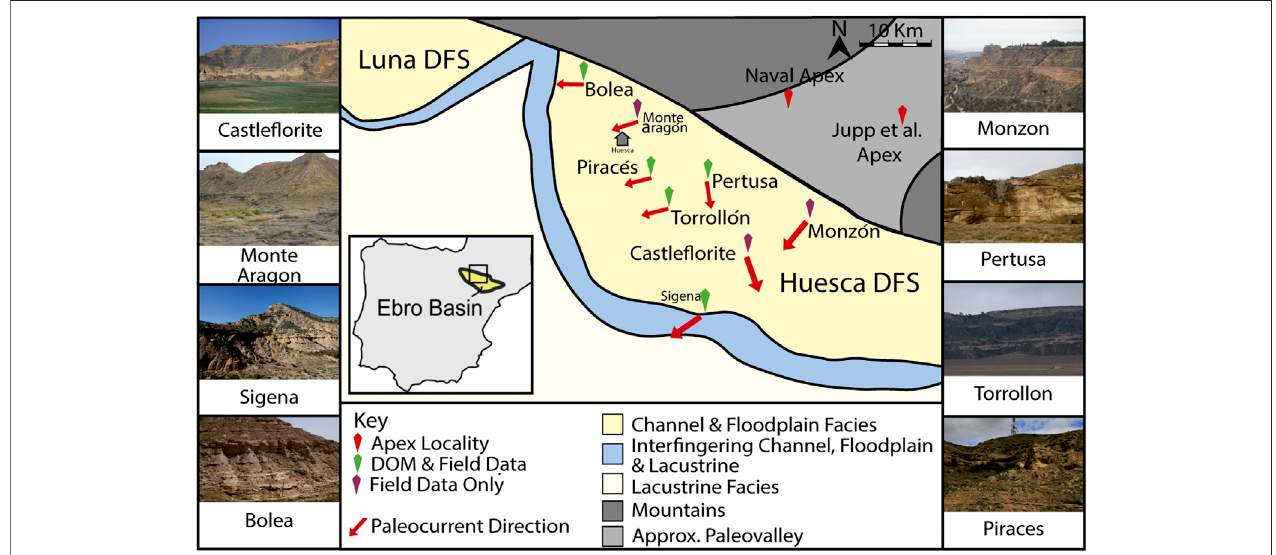
FIGURE 1 | Location map showing the Ebro Basin. DOM (cid:1) digital outcrop models. Position of two calculated apices (Naval and Jupp et al., 1987) are plotted (see text fordiscussion)aswellaspositionofeach studylocated.Faciesmapmodi fi edfromNichols(2017).See SupplementaryMaterial forpreciseoutcroplocationsand